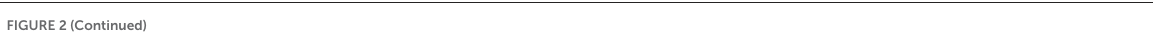
FIGURE2(Continued) relationships of Mononegavirus and Rhabdovirus. Red dots marked with 1 to 4 represent Nuomin chuvirus, taiga tick nigecruvirus , Chimay rhabdovirus, and Norway mononegavirus -like virus 1 from Ixodes persulcatus, respectively. Green dots marked with 1 and 2 represent Rhipicephalus -associated rhabdo-like virus and America dog tick rhabdovirus from Dermacentor silvarum, respectively. Blue dots marked with 1 to 3 represents blacklegged tick rhabdovirus-1, Bole tick virus 2, and Manly virus from Haemaphysalis concinna, respectively.